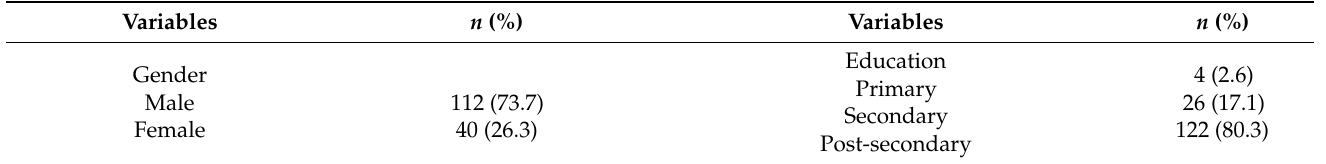
Table 2. Demographic characteristics of